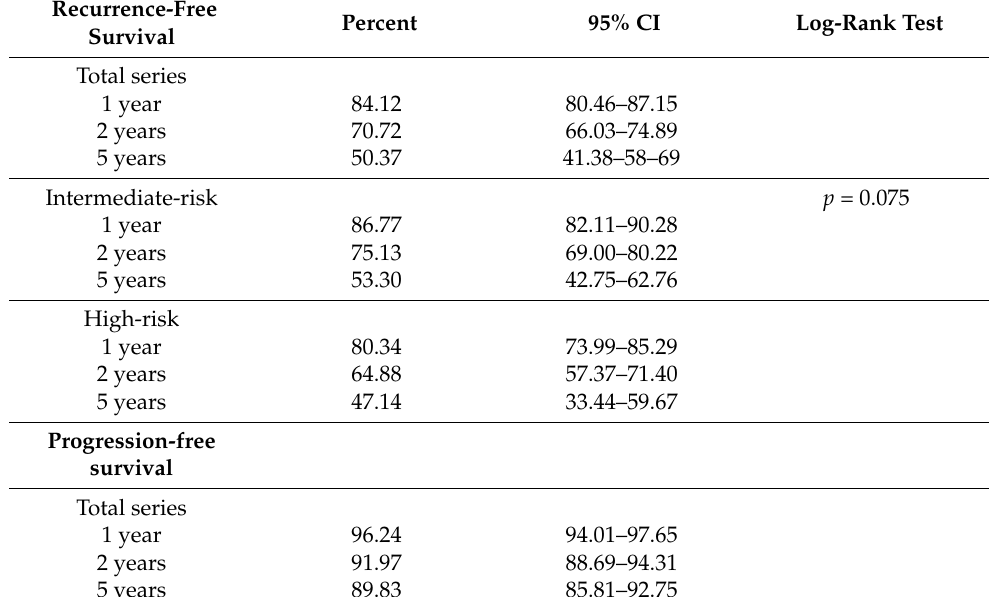
Table 2. Recurrence, progression and overall mortality at different times with interval limits for the FAS population ( n = 502), and for intermediate ( n = 297) and high-risk patients ( n = 205).